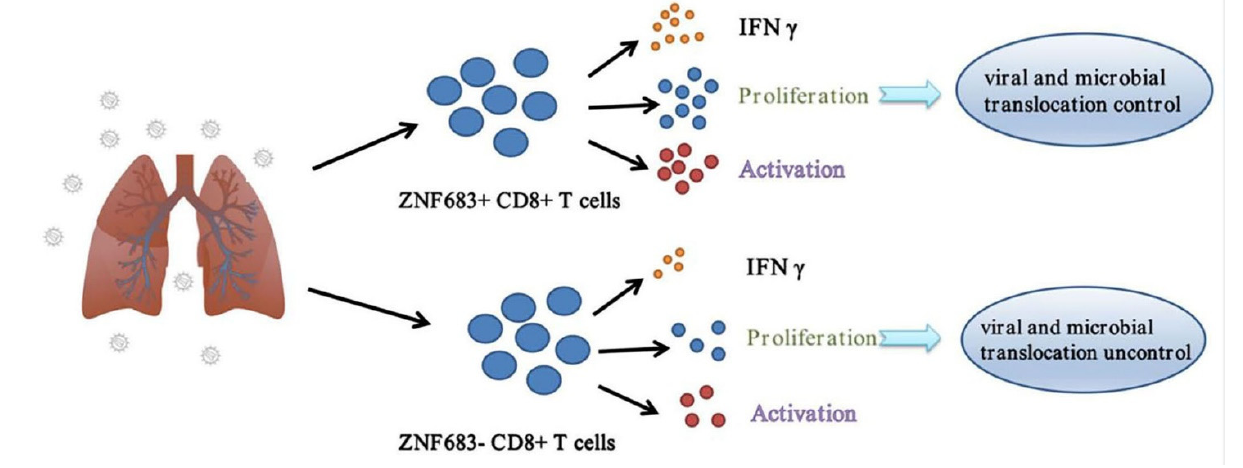
Figure 7. Role of ZNF683 in HIV infection.